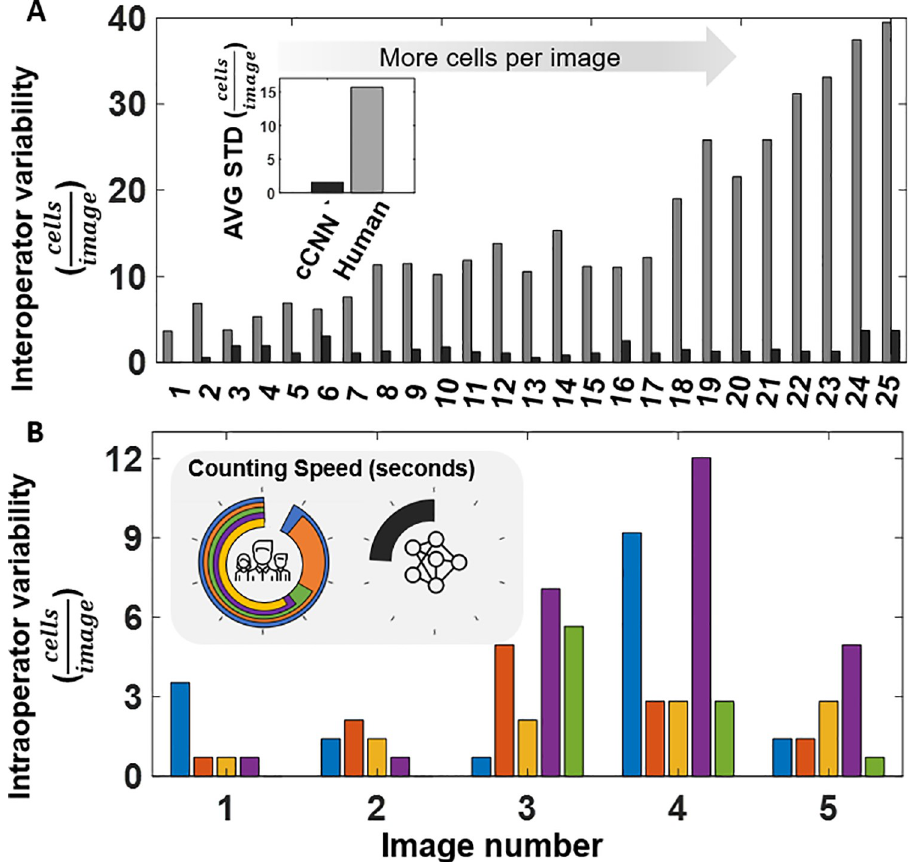
Fig 6. Comparing consistency and repeatability of manual cell counting. (A) Standard deviation (STD) as a measure of variance of cell counts across 25 microscope images (ordered in increasing number of cells per image) using manual counting from five separate human counters (interoperator variability) benchmarked against the advanced rotation (AR) trained cCNN algorithm. Average variance of human subjects was 10.2 times larger than that of the cCNN algorithm (insert). (B) Standard deviation of each test subject when counting a duplicate image randomized in their set (intraoperator variability). Images 1 through 5 presented in the order of increasing cell population (Supplement 13 in S1 File ). Total time required to count cells on all images for each operator is presented in the pie chart (inset). Full circle is 1000 seconds, tick marks are set to 100 seconds. Each individual is represented with a different color (Blue–Person 1; Orange–Person 2; Yellow–Person 3; Purple–Person 4; Green–Person 5). If the data from a specific person is not present, then their variability was 0 cells/image.